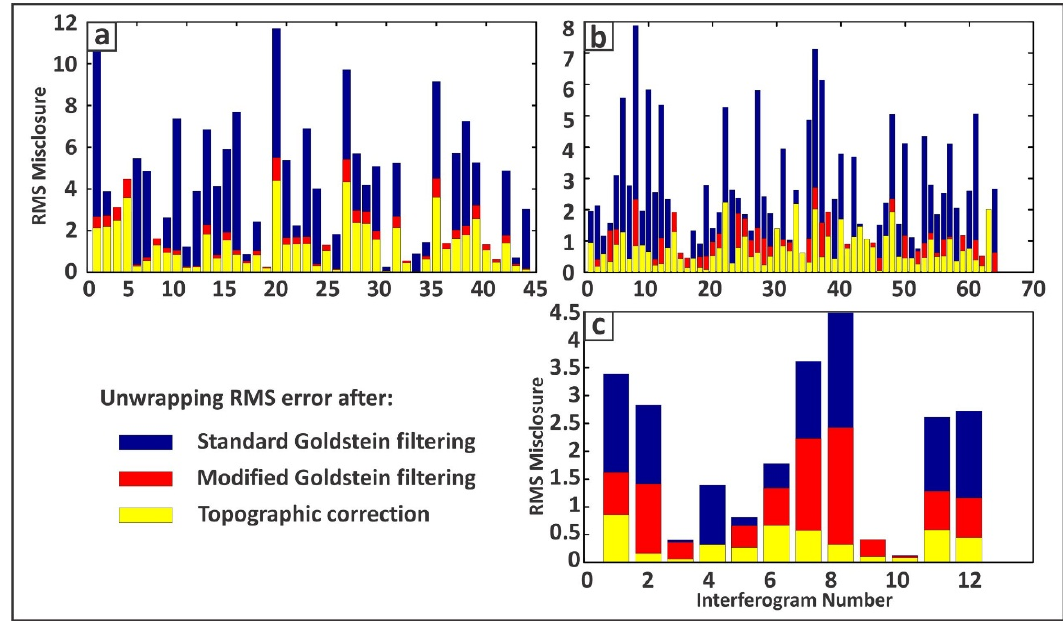
Figure 18. RMS misclosure of each interferogram for the all datasets. ( a ), ( b ) and ( c ) correspond to Envisat descending, ascending, and ALOS dataset respectively. Blue corresponds to the standard Goldstein filter (implemented in StaMPS), red to our modified filtering, and yellow to topographic correction using linear